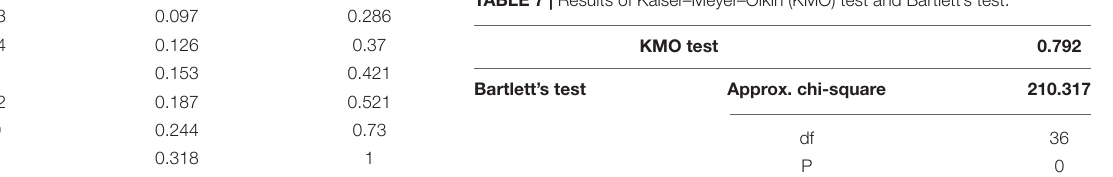
TABLE 7 | Results of Kaiser–Meyer–Olkin (KMO) test and Bartlett’s test.